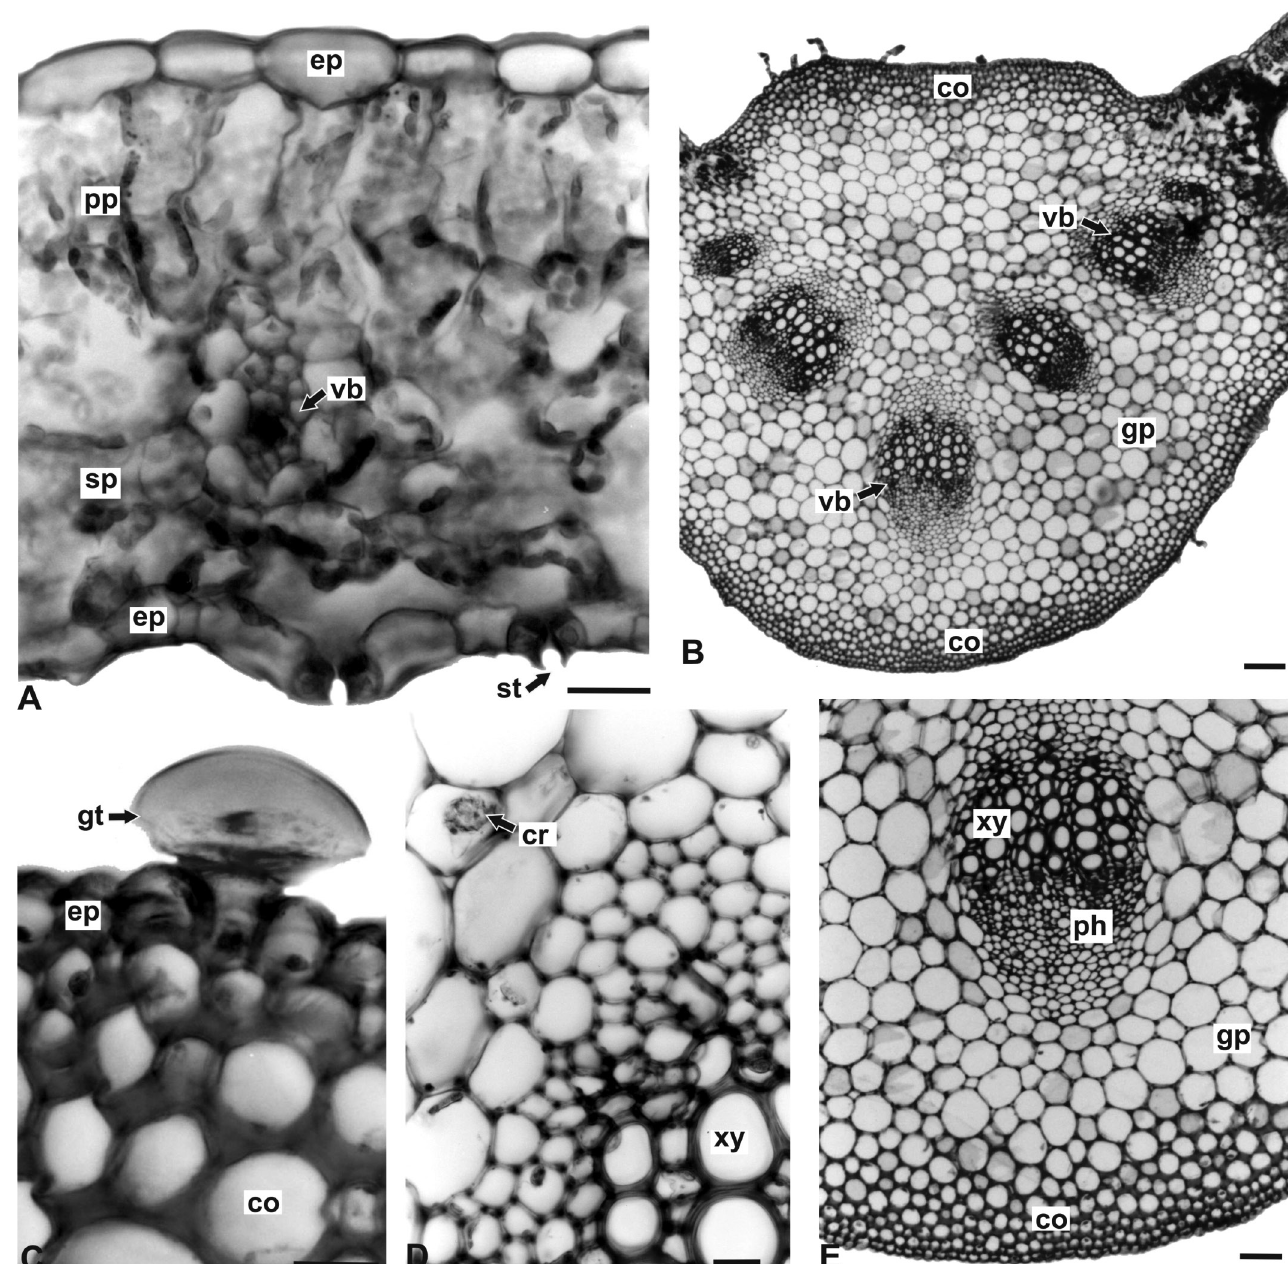
FIGURE 2 - A-E: Gymnanthemum amygdalinum (Delile) Sch.Bip. ex Walp. – leaf, transverse section: A. Interveinal region, showing dorsiventral mesophyll and a minor collateral vascular bundle; B. Midrib organization; C. Detail of a glandular trichome and angular collenchyma of the midrib; D. Calcium oxalate crystal near a vascular bundle; E. Collateral vascular bundle of the midrib. Abbreviations: co – collenchyma, cr – crystal of calcium oxalate, ep – epidermis, gp – ground parenchyma, gt – glandular trichome, ph – phloem, pp – palisade parenchyma, sp – spongy parenchyma, st – stomatum, vb – vascular bundle, xy - xylem. Bar = 100 µm (B), 50 µm (E), 20 µm (A, C,